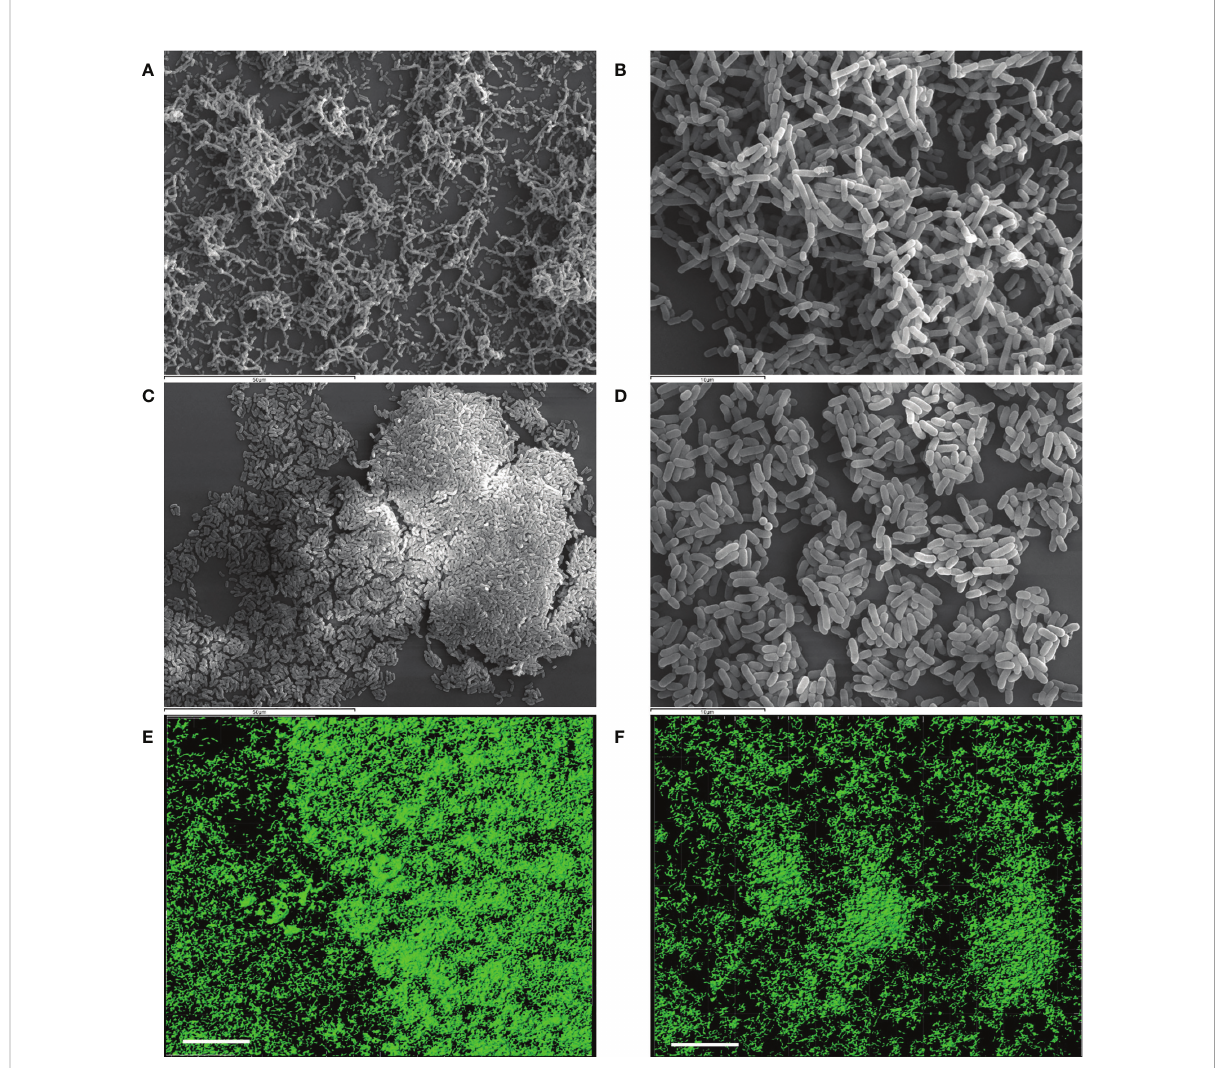
FIGURE 2 Representative images of bio fi lms (48 h) of L. reuteri 7SNG3 obtained by SEM at 1,000× (A) and 3,000× (B) , and by CLSM (E) . Representative images of bio fi lms (48 h) of L. salivarius 20SNG2 bio fi lms obtained by SEM at 1,000× (C) and 3,000× (D) , and by CLSM (F) . For CLSM image acquisition, cells (in green) were stained with SYTO 13. CLSM scale bar: 50